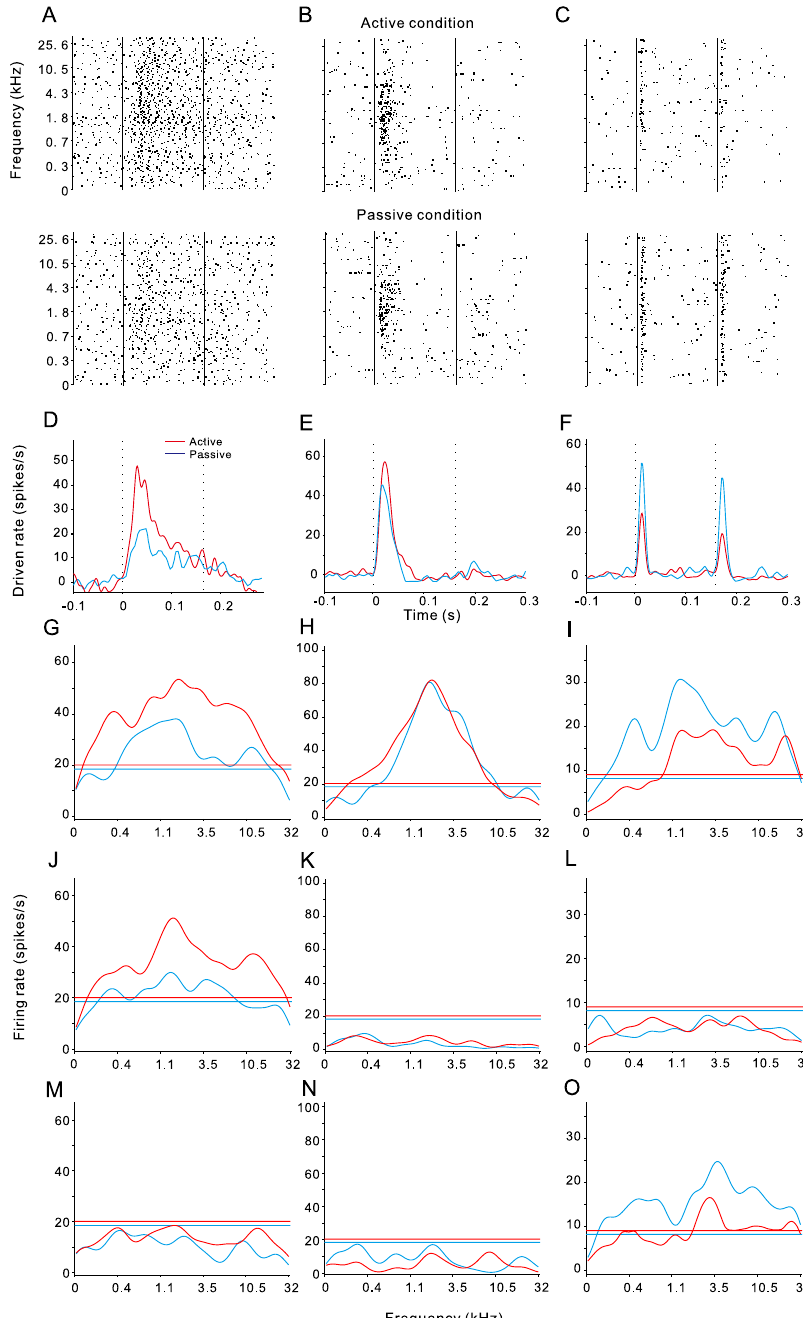
Figure 3. Examples of tone-evoked neural responses affected by task-engagement. ( A – C ) Raster displays of spike discharges in response to pure-tone stimuli at 125 different frequencies. Top and bottom panels show the results under the active and passive conditions, respectively. The two vertical lines mark the onset and offset of sound stimuli. Data in ( A ) were recorded from PAF, ( B ) from A1, ( C ) from PU. ( D – F ) Peri-stimulus time histograms (PSTHs) constructed from the raster displays under different conditions. The two vertical lines mark the onset and offset of sound stimuli. ( G – I ) Frequency tuning curves of onset segment, in which firing rate counted from 0 to 50 ms after stimulus onset is plotted against tone frequency. Horizontal lines show the thresholds to calculate BW. ( J – L ) Frequency tuning curves of ongoing segment (50 to 160 ms after stimulus onset). ( M – O ) Frequency tuning curves of offset segment (0 to 50 ms after stimulus